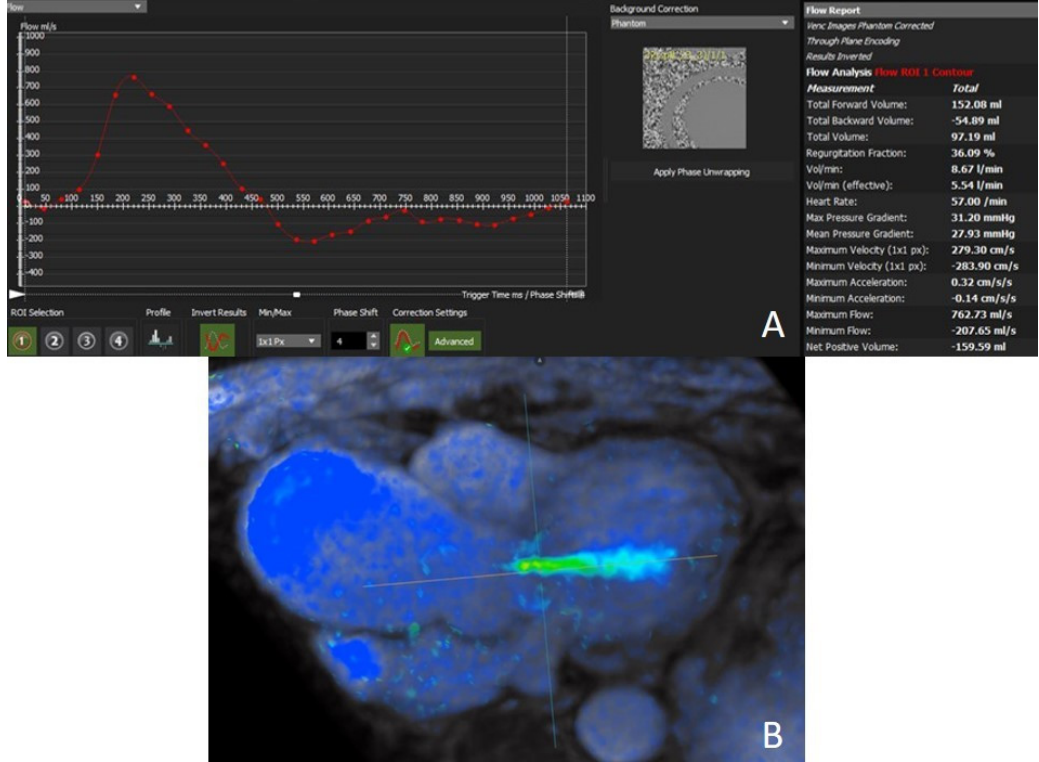
Figure 3. Aortic regurgitant flow quantification: ( A ) phase contrast imaging; ( B ) 4D flow tech-